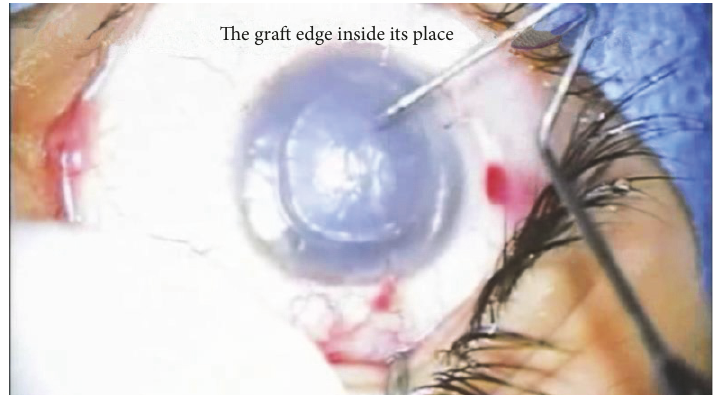
Figure 15: Reappearnce of corrugations denoting good apposition of the graft to the back of the stroma.